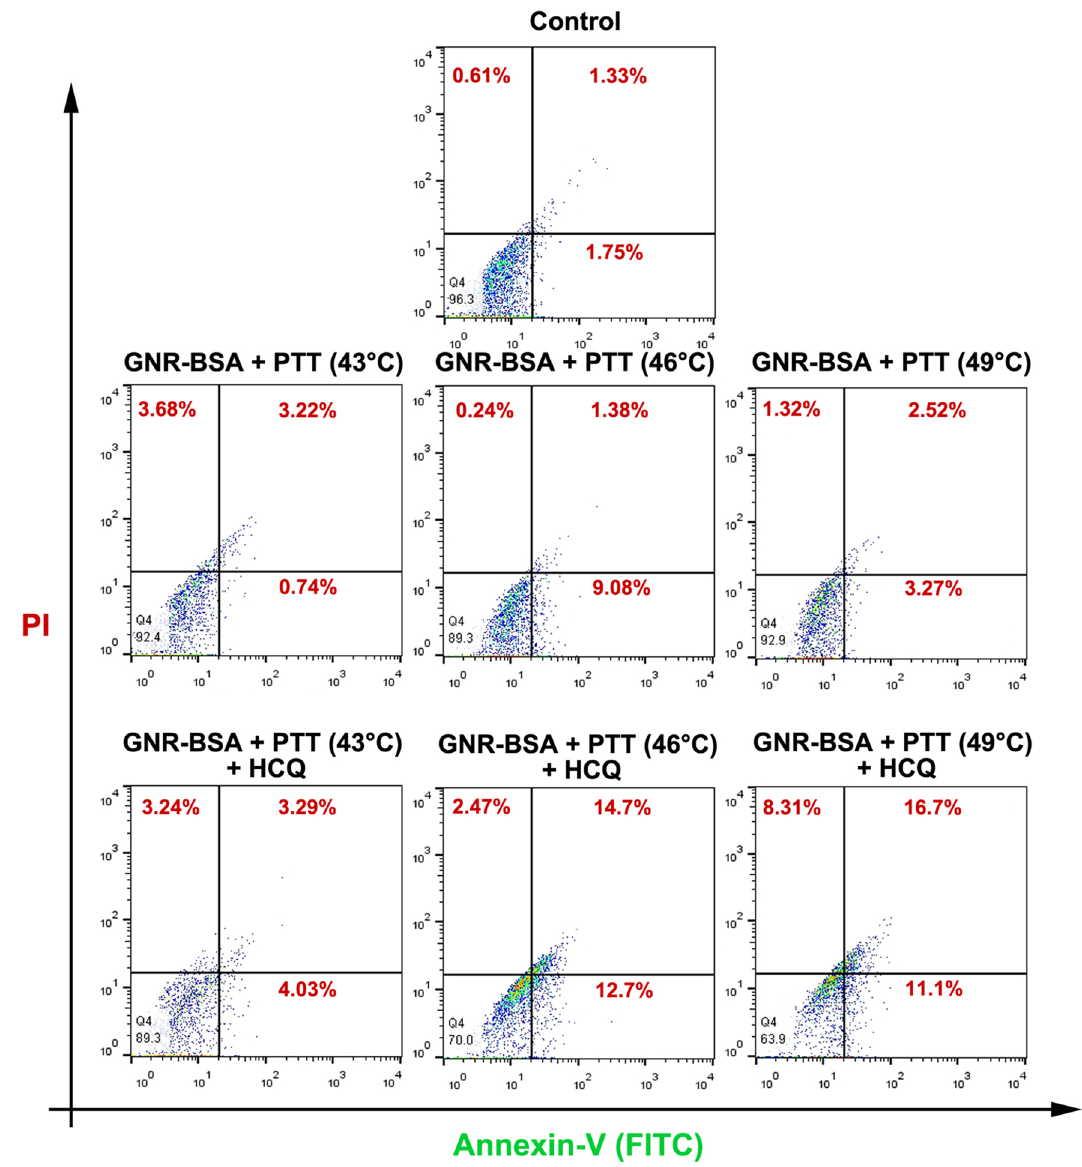
Figure 3. Flow cytometric analysis of apoptosis and necrosis using Annexin-V and PI staining. Data showed the induction of apoptotic CSCs by increasing temperature from low to high